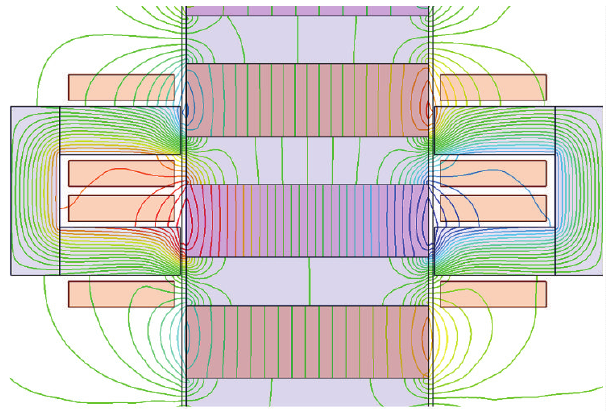
Figure 31: Magnetic flux at 𝑡 = 30 ms.